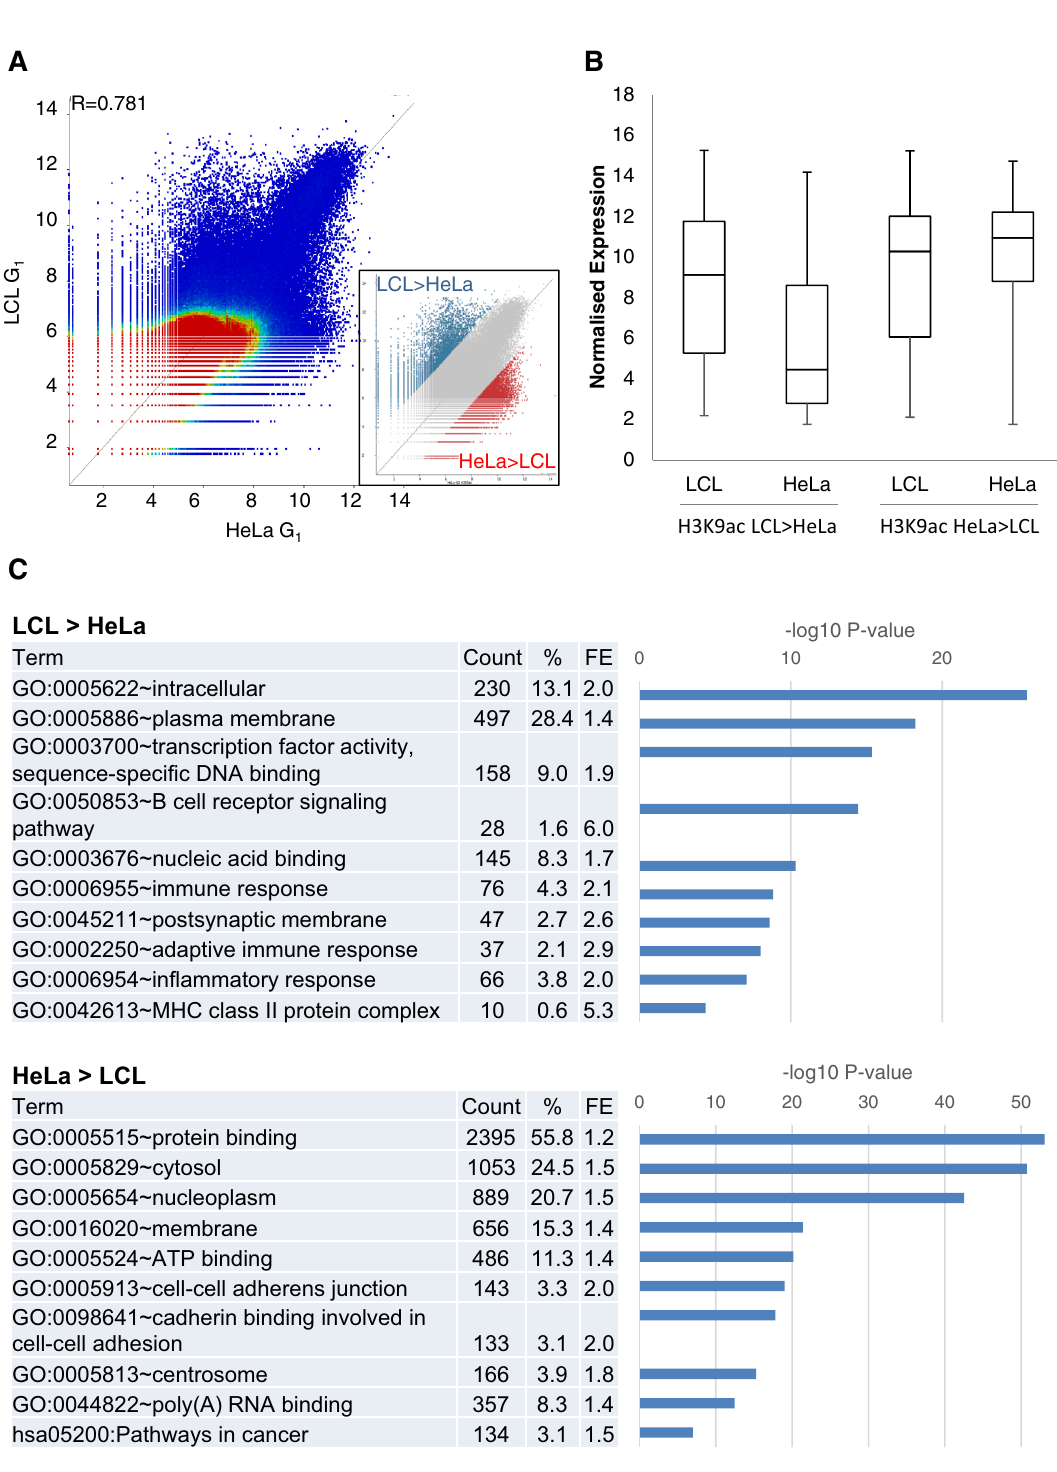
Figure 3. Differences in H3K9ac pattern between LCL and HeLa reflect cell-type-specific transcription. ( A ) Dotplot comparison of H3K9ac in 5 kb windows between LCL and HeLa in G 1 . The outlying 3% on each side of the distribution are highlighted (inset). ( B ) The expression of genes contained within these outlying regions was measured by microarray in LCL and HeLa. ( C ) Ontology analysis for functional enrichment was carried out on genes in each outlying region using DAVID. Count: number of significant genes with specific annotation; %: proportion of genes in each gene list with specific annotation; FE: Fold